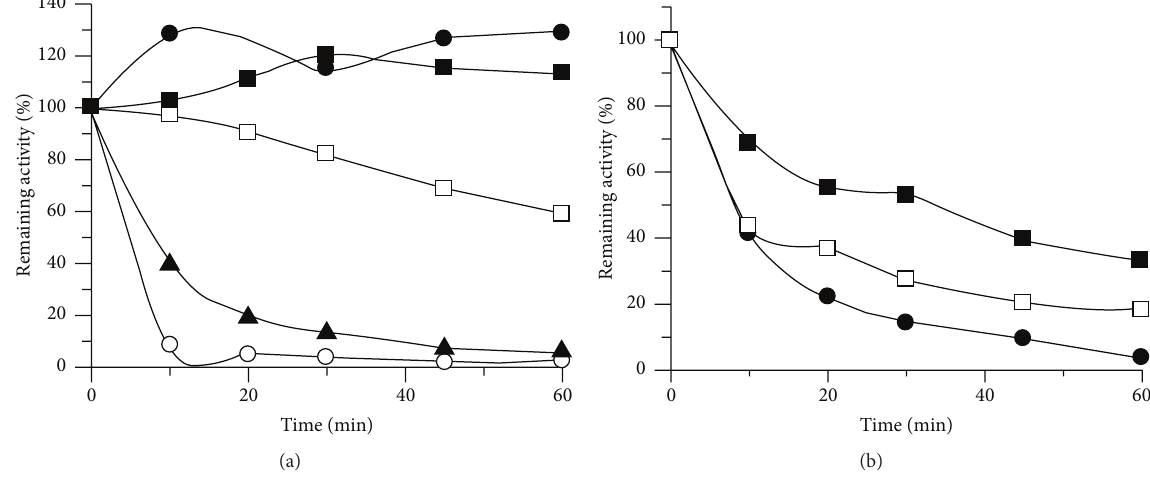
Figure 7: Thermostability of (a) PeiW and (b) PeiP in the presence and absence of Ca 2+ . (a) Thermostability of PeiW, in the presence of Ca 2+ , ◼ 75 ∘ C, e 80 ∘ C, and 󳵳 85 ∘ C, and in the absence of Ca 2+ , ◻ 75 ∘ C, I 80 ∘ C. (b) Thermostability of PeiP, in the presence of Ca 2+ , ◼ 70 ∘ C, e 75 ∘ C, and in the absence of Ca 2+ , ◻ 70 ∘ C. Initial specific activity values (Umg −1 ) were 0.253, PeiW and 0.0429, PeiP.